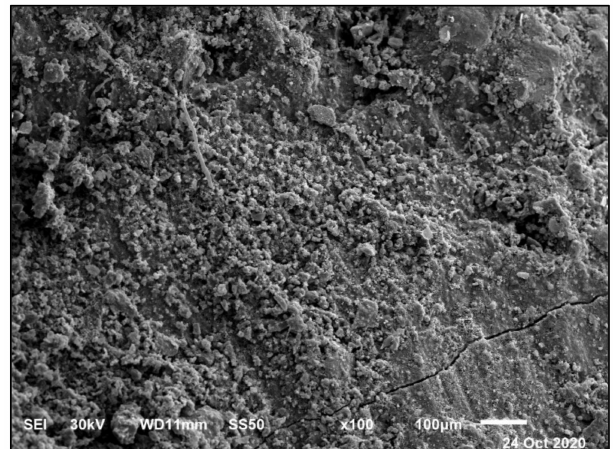
Figure 24. SEM of mix Z1 under 500 ◦ C fire exposure at 180 days at a scale of 100 µ m.